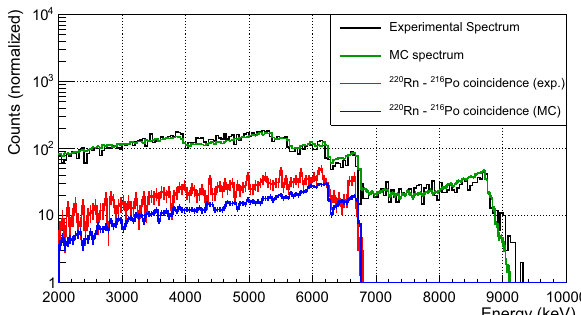
Fig. 5 Measured spectrum (black) and selection of 220 Rn– 216 Po delayed coincident events (red). We show the MC simulated spectrum of the full 232 Th chain (green) normalized to the same integral of the measured spectrum in the E > 2 MeV range, and the corresponding selection of 220 Rn– 216 Po coincidences (blue). The difference between the selected coincidences in the experimental data with respect to the MC simulations is compatible with the number of random coincidences estimated from the plateau in the fit of Fig. 6